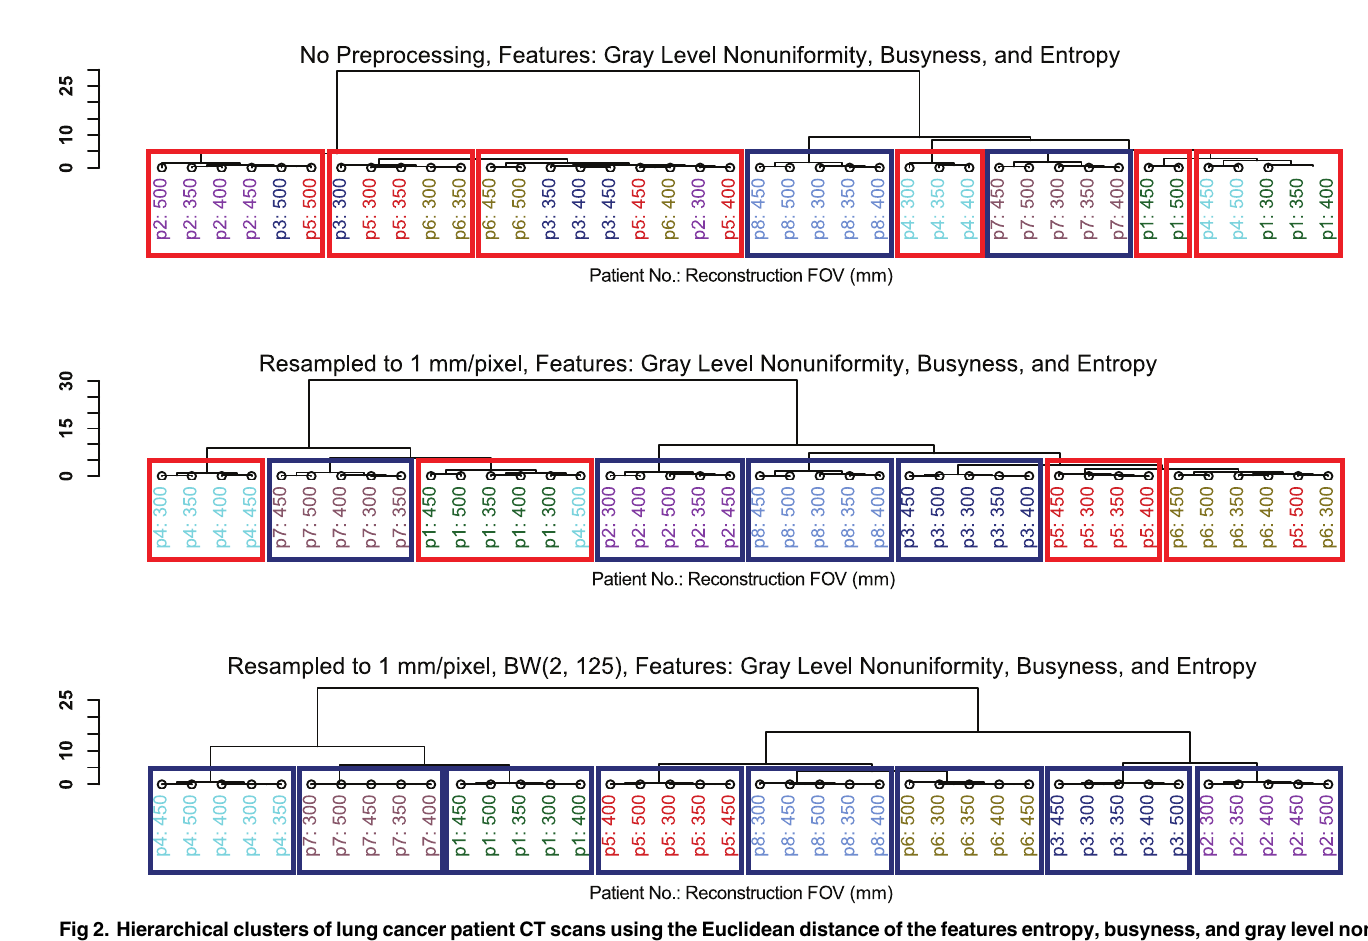
Fig 2. Hierarchical clusters of lung cancer patient CT scans using the Euclidean distance of the featuresentropy, busyness, and gray level non- uniformity. The features were extracted from images that had (a) no preprocessing, (b) resampling to 1 mm/pixel, and (c) resamplingto 1 mm/pixel and filtering with a Butterworth filter (order 2, frequency cutoff 125). Boxes indicate incorrect (red) and correct (blue) groupings of the 5 FOV scans for each patient.